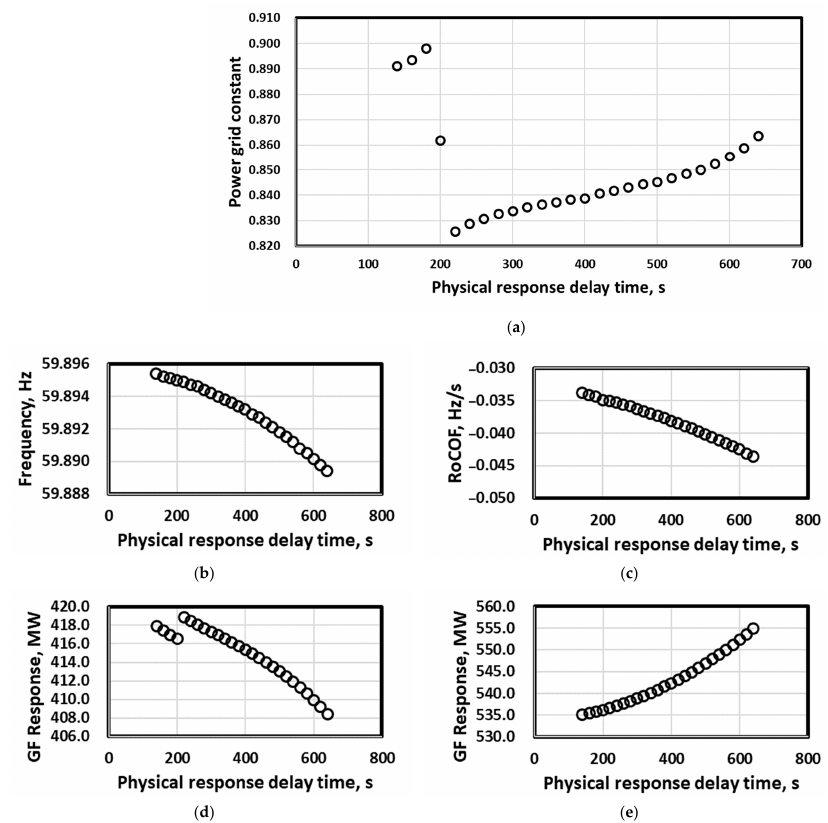
Figure 11. Main results of transient characteristic trajectory analysis considering the effect of physi- cal response delay time; ( a ) Power grid constant at nadir frequency point; ( b ) Nadir frequency; ( c ) Average RoCoF; ( d ) GF Response at starting BESS; ( e ) Maximum GF Response.